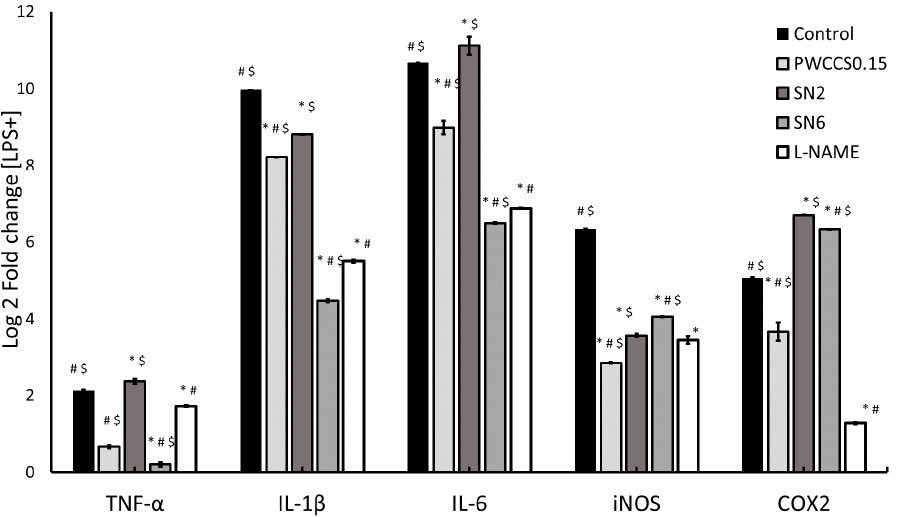
Figure 5. Inflammatory gene expression in LPS-stimulated RAW 264.7 cells. Data are relative expression levels of TNF- α , IL-1 β , IL-6, iNOS, and COX-2 from control (+LPS), PWCSS0.15, SN2, SN6, and L-NAME. Data represent the mean ± SEM of three replicates. Statistical significance was evaluated by Dunnett post-hoc test, * p < 0.05 compared with control (+LPS), # p < 0.05 compared with SN2 and $ p < 0.05 compared with 200 µ M L-NAME.